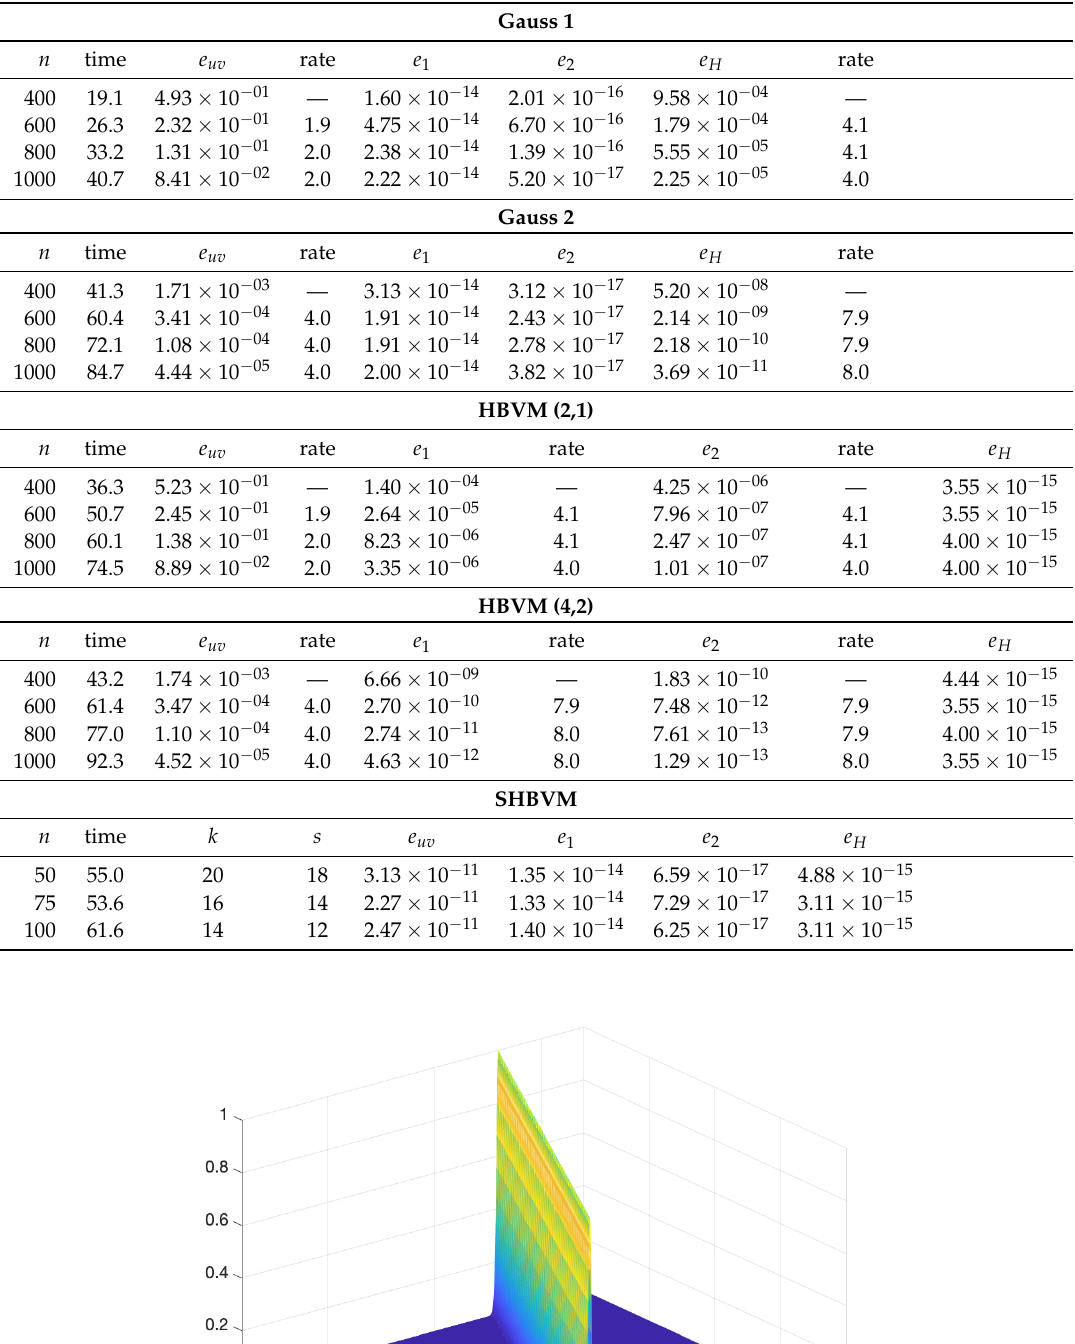
Table 2. Numerical solution of the nonlinear Schrödinger Equation (94) using a time-step h = 20/ n . Gauss